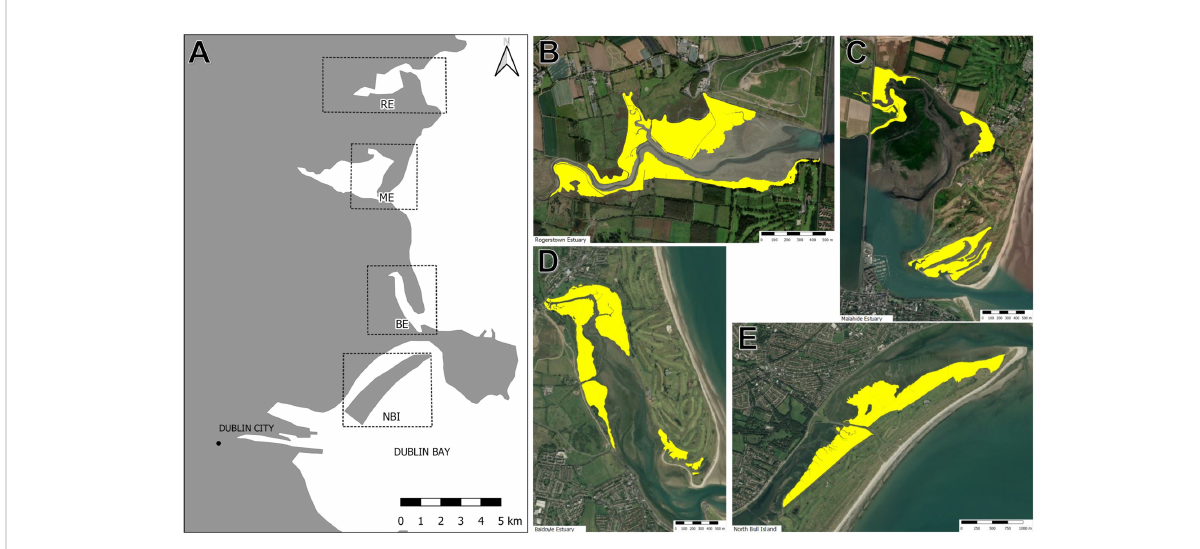
FIGURE 1 The location of each studied site in Dublin City and County (A) with the saltmarsh area highlighted in yellow; where (B) is Rogerstown Estuary (RE), (C) is Malahide Estuary (ME), (D) is Baldoyle Estuary (BE), and (E) is North Bull Island (NBI). Background maps: Bing satellite map. Shape fi les adapted from